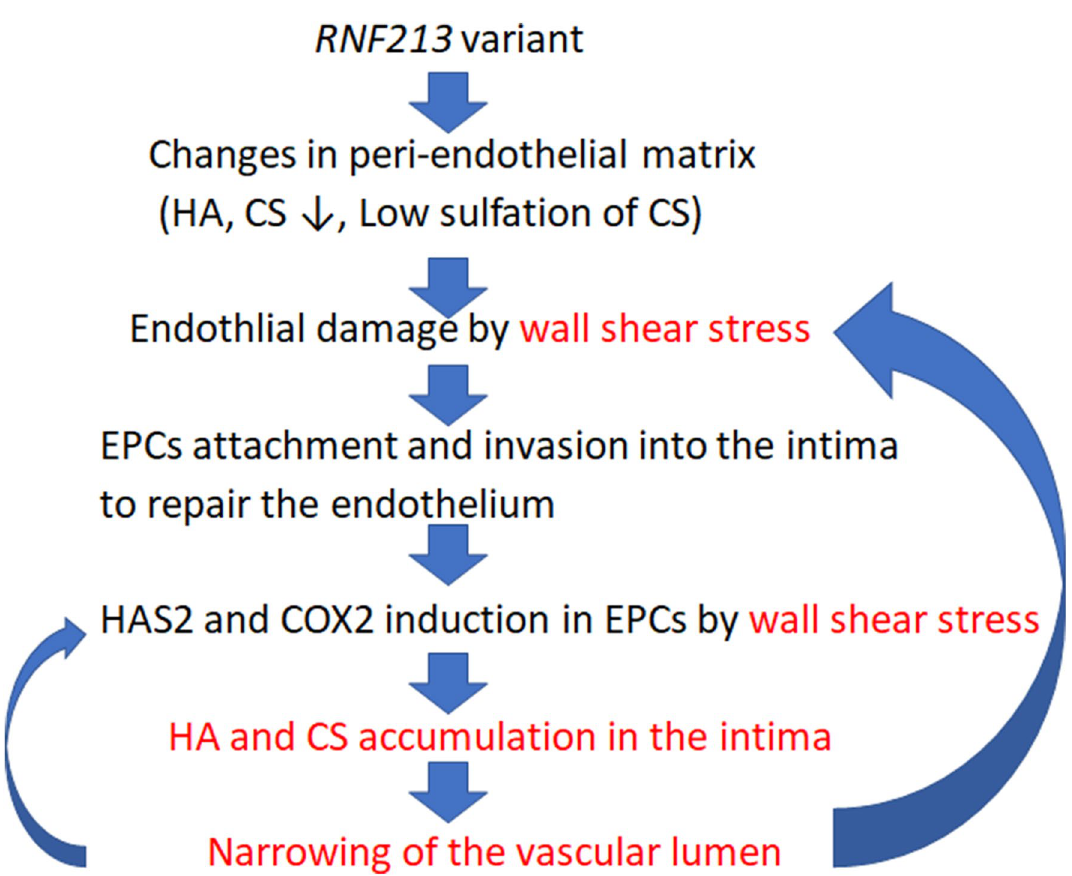
Figure 8. Proposed pathogenesis of vascular occlusion in MMD. Under normal conditions, the intact peri- endothelial matrix protects against vascular shear stress by relaxing VSMCs through the enhanced production of nitric oxide. In MMD, decreased production of CS leads to changes in the peri-endothelial matrix, including decreased HA, which makes the endothelium susceptible to vascular shear stress. EPCs infiltrate through the damaged endothelium, with HAS2 and COX2 subsequently induced in EPCs by shear stress or cytokines. The accumulation of HA in the intima, produced by the infiltrated EPCs, results in eccentric thickening of the intima and narrowing of the vascular lumen, which further increases shear